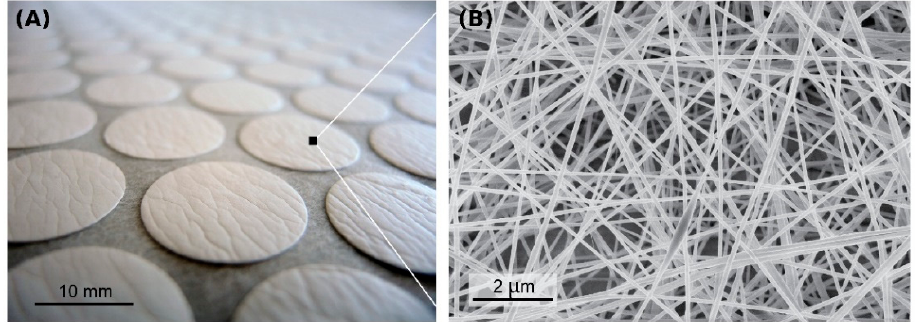
Figure 6. A photograph of the nanofibrous layer cut into 912 round pieces with a diameter of 23 mm ( A ). An electron microscope image of the structure of the nanofibrous layer ( B ). The statistical data obtained by calculating the area weights of the individual round pieces of the nanofibrous layer are provided in the chart in Figure 7. The average area weight of the pieces was AW EB = (17.20 ± 0.72) g·m − 2 . The coefficient of variation of the area weight of the evaluated pieces was 4.2%. A total of 879 pieces, i.e., 96.3% of all the pieces, had an area weight that was within the ±10% deviation range acceptable in pharmaceuti- cal applications.